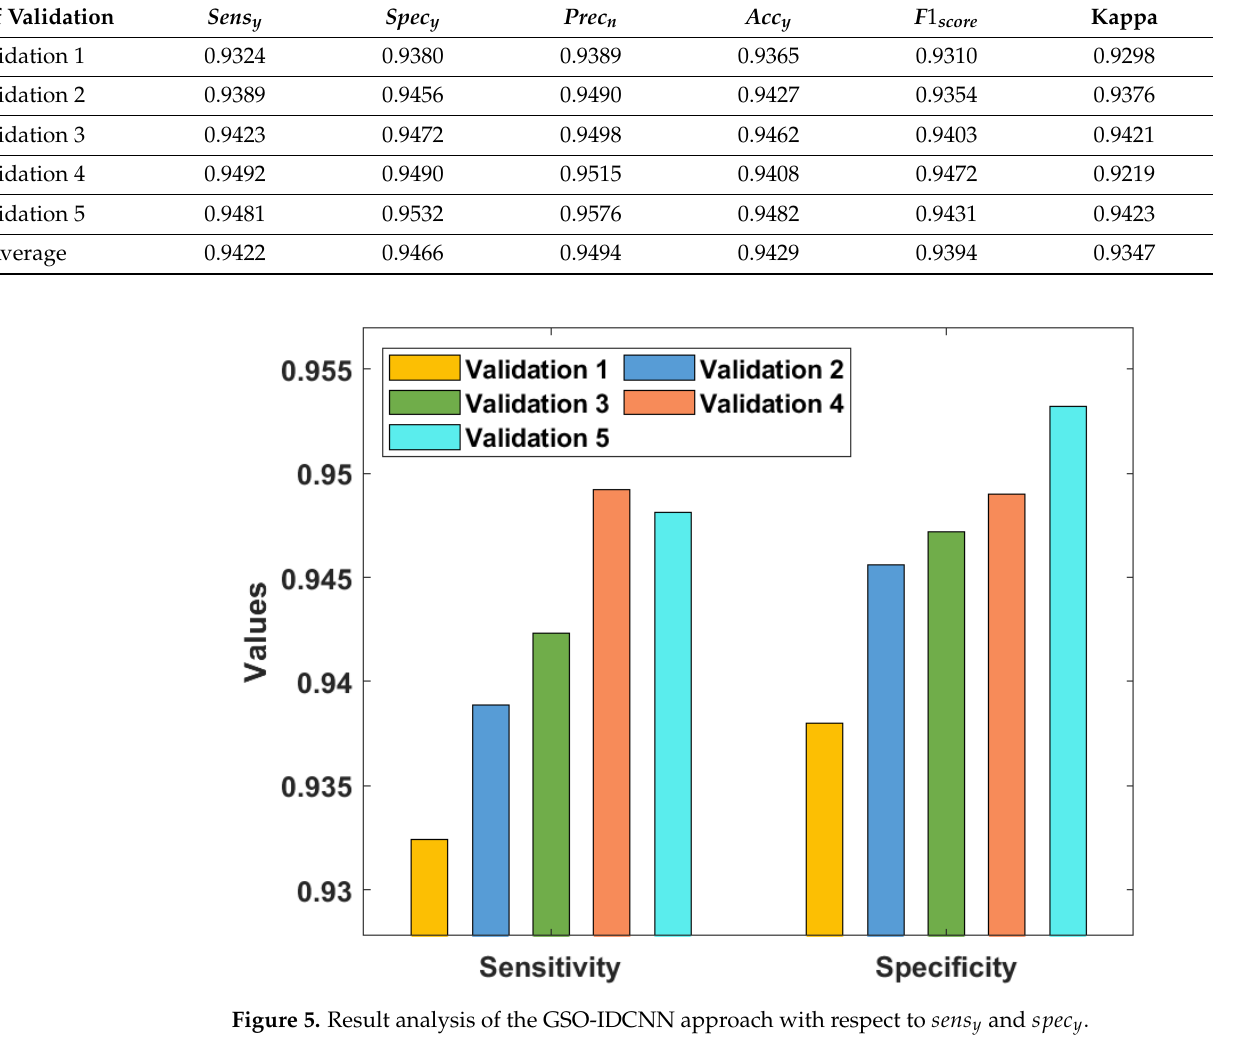
Figure 6. Result analysis of the GSO-IDCNN technique with respect to 𝑃𝑟𝑒𝑐 𝑛 and 𝐴𝑐𝑐 𝑦 .